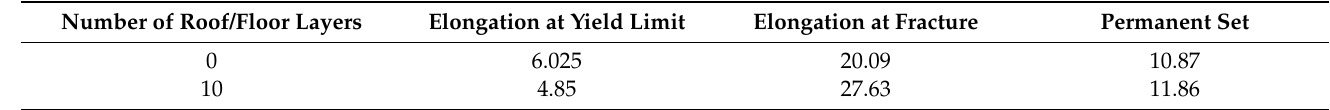
Table 6. Elongation values for the selected numbers of roof/floor layers (mm).